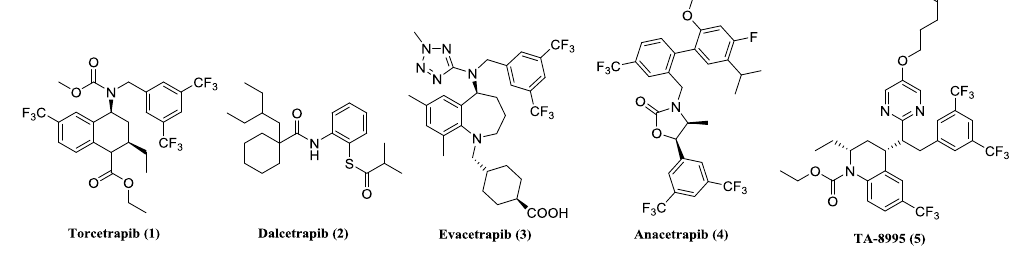
Figure 1. Representative CETP inhibitors.